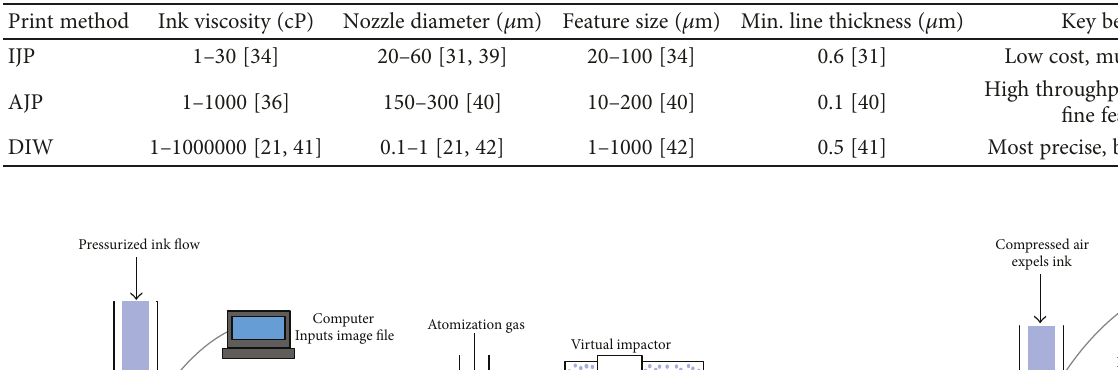
Table 1: Comparison of direct write printing